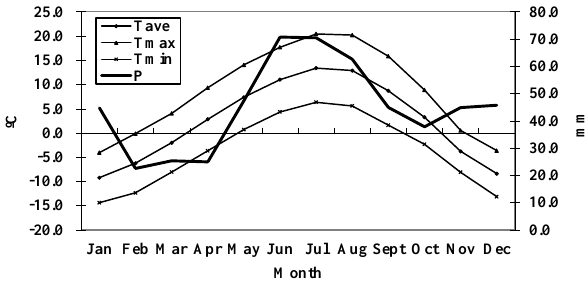
Figure 2 Long-term (1964 to 2009) mean monthly temperature (ºC) and precipitation 933 Fig. 2. Long-term (1964 to 2009) average monthly temperature ( ◦ C) and precipitation